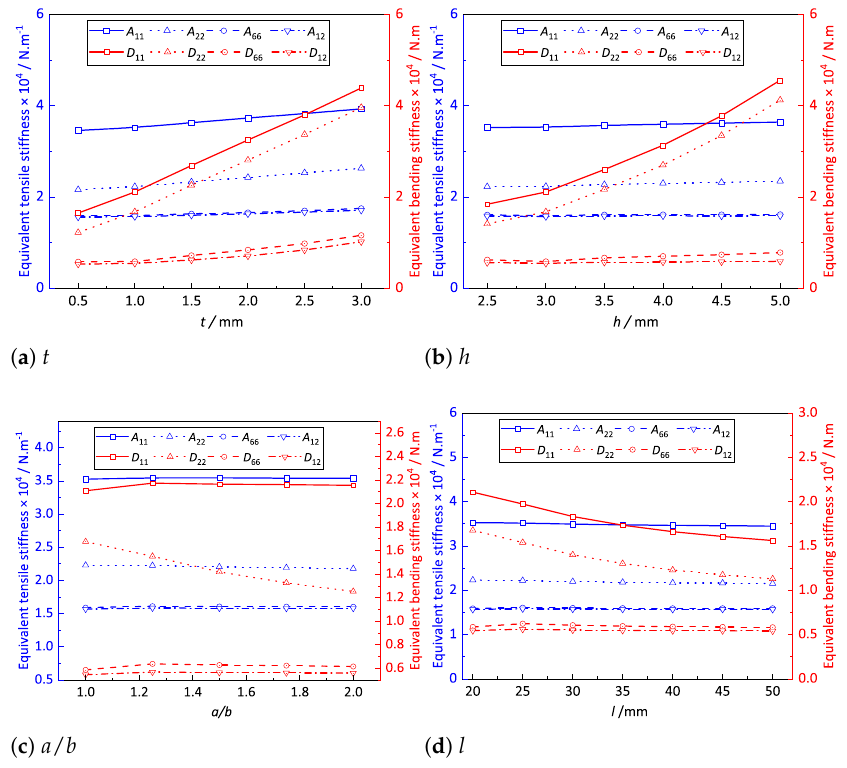
Figure 12. Effects of the structural parameters on the equivalent plate properties of the